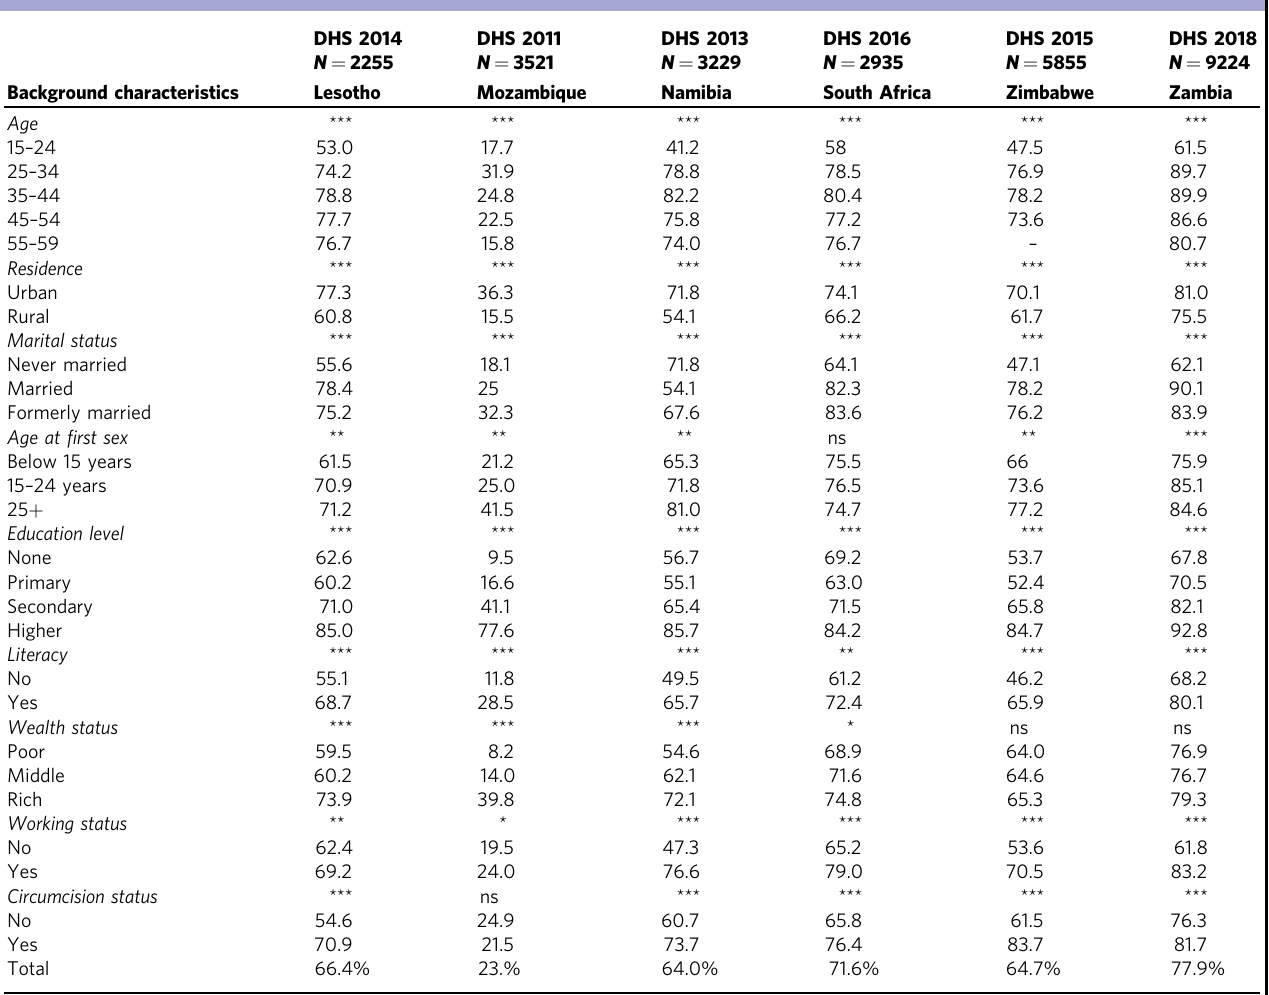
Table 3 Percentage distribution of men who tested for HIV and received results in the last 12 months by background characteristics, Southern